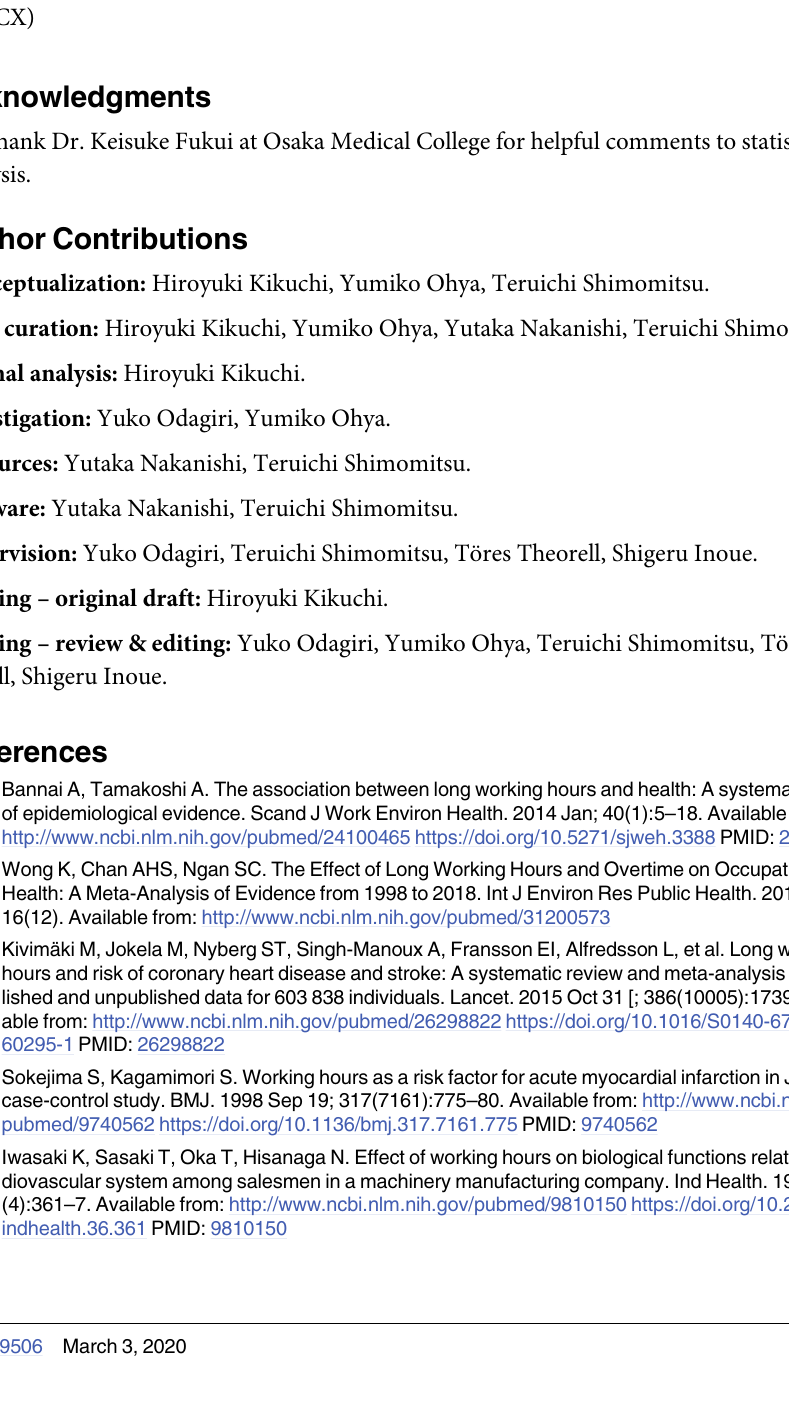
S1 Table. A Specific items with internal consistency of the scales of Brief Job Stress Question- naire used in the study. B Correlation coefficient between stress response scales in BJSQ. S2 Table. Association between overtime work hours and stress responses: Multiple linear regression results with multiple